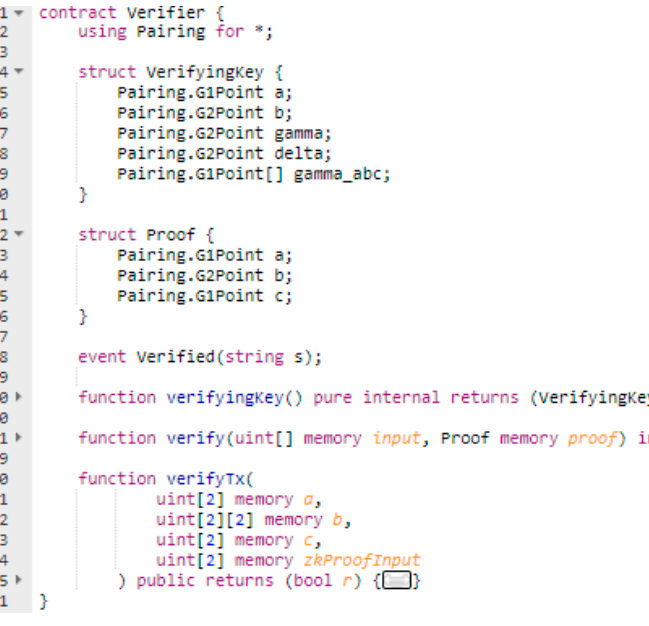
Figure 4. Aggregator smart contract using the verifier key for DR validation.